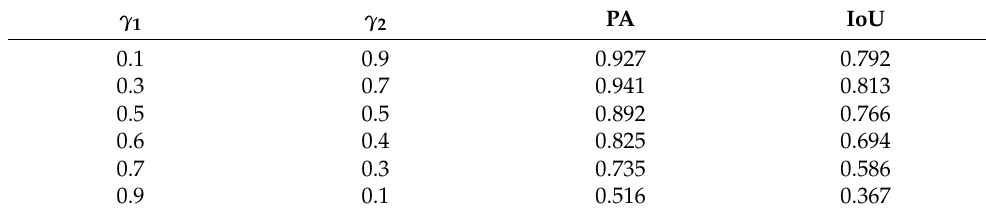
Table 2. Influences of loss function